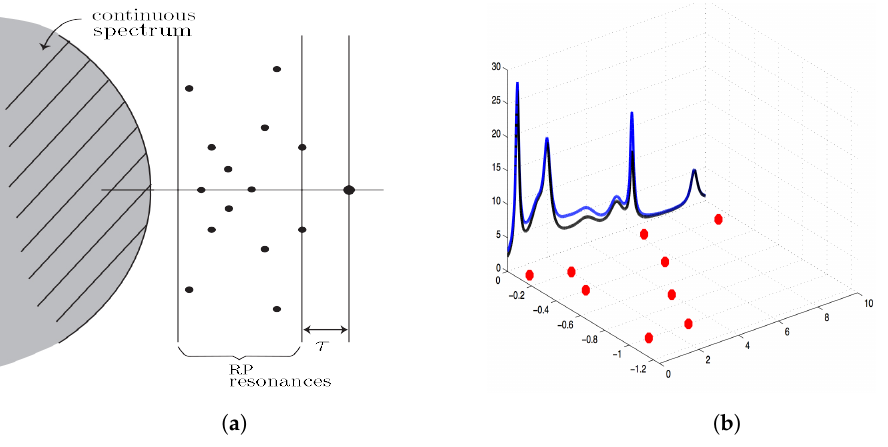
Figure A1. ( a ) The Ruelle–Pollicott (RP) resonances are the isolated eigenvalues of the Fokker–Planck operator, A , defined in (A3); they are represented by red dots in ( b ) and by black dots here. The rightmost vertical line represents the imaginary axis above which the power spectrum lies; see ( a ) for another perspective. The rate of decay of correlations is controlled by the spectral gap τ (not to be confused with τ in (A6)); see [56,85]. ( b ) The imaginary part of the RP resonances corresponds to the location of a peak in the PSD (black curve lying above the imaginary axis) and the real part to its width. In blue is represented a reconstruction of the PSD based on RPs; a discrepancy is shown here to emphasize that in practice, the RPs are very often only estimated/approximated; see [56,71] (courtesy of Maciej Zworski). ( a ) Schematic of the spectrum of A given in (A3). ( b ) Correspondence between the PSD and RP resonances according to